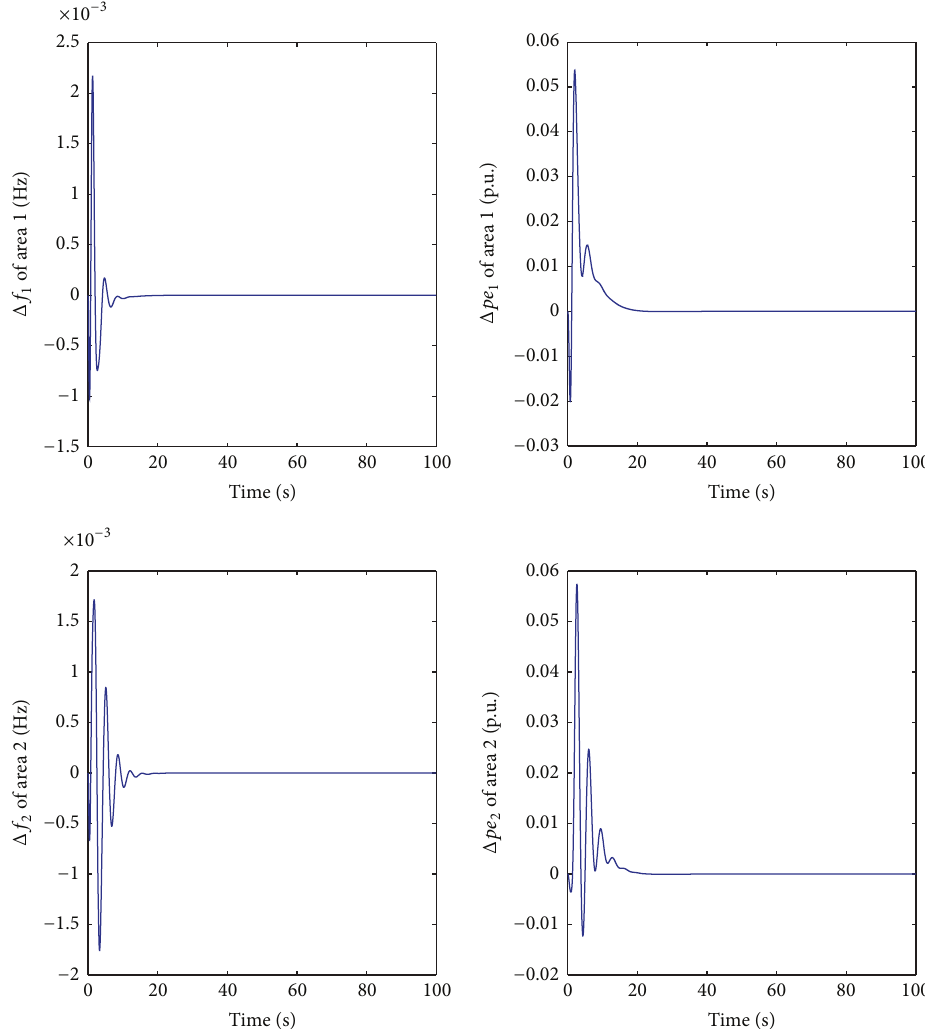
Figure 4: Step load disturbance responses of the original subsystems when 𝐸 1,2 varies from 1 to